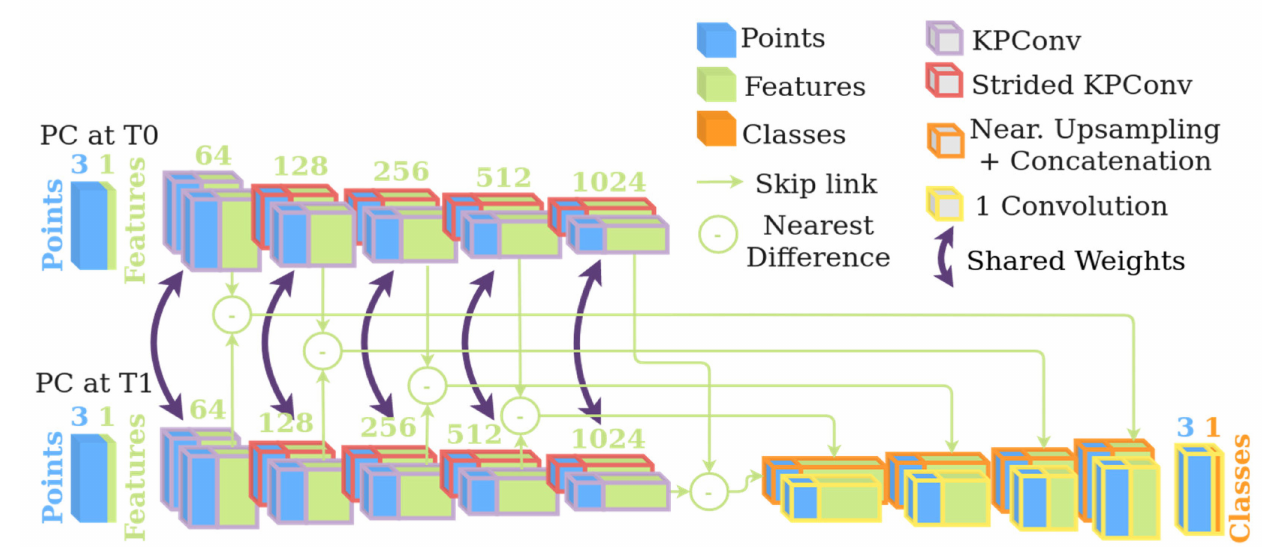
Figure 12. Siamese KPConv network architecture. Source: Image adopted from